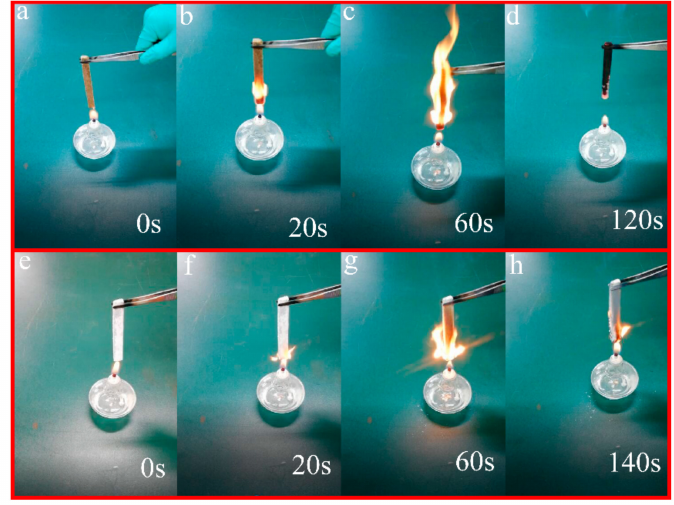
Figure 8. Combustion process of ( a – d ) LC; ( e – h ) LC coated with